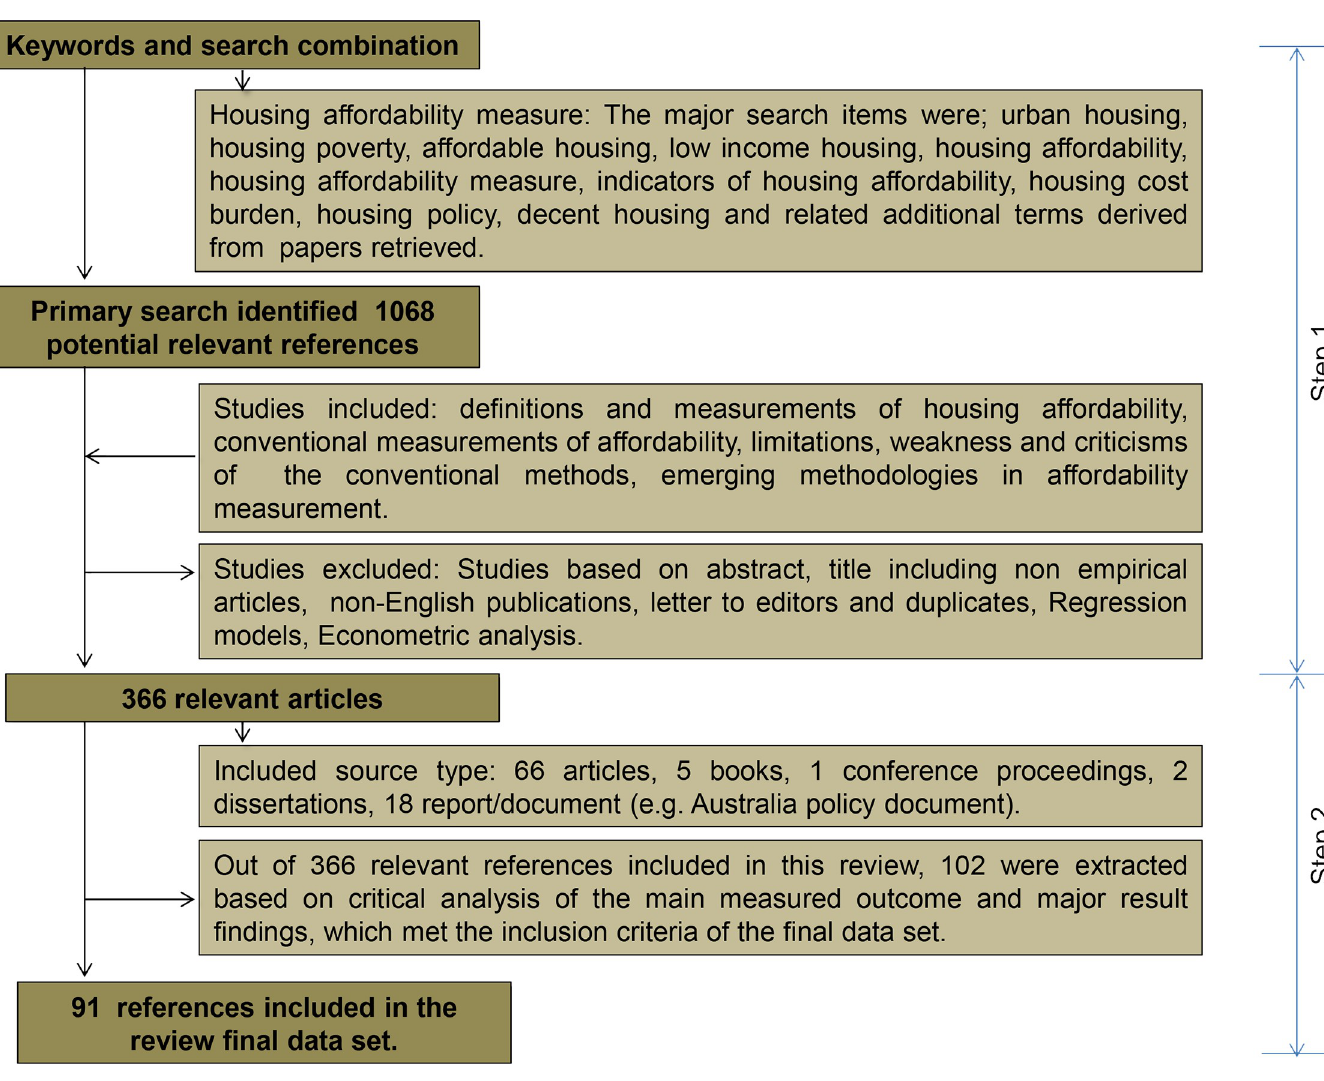
Fig 1. The literature review